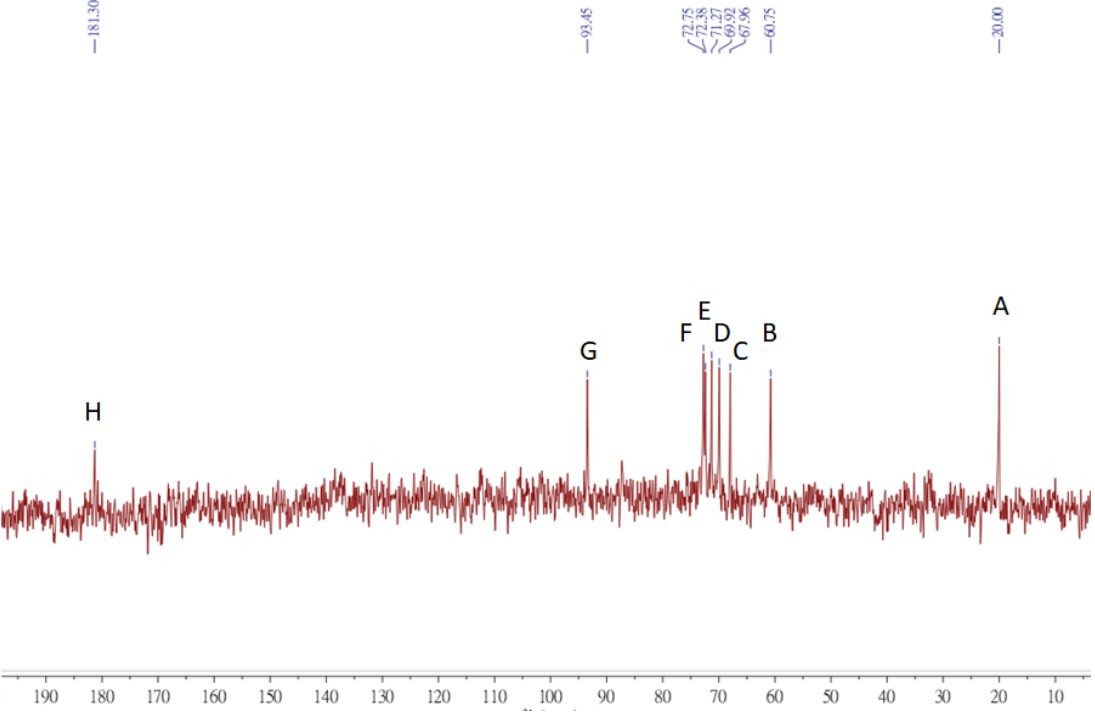
Figure 9. 13C NMR spectroscopy of PNP-80. A–H: Matching capital letters represent carbon signals at different positions on the PNP-80 structure.